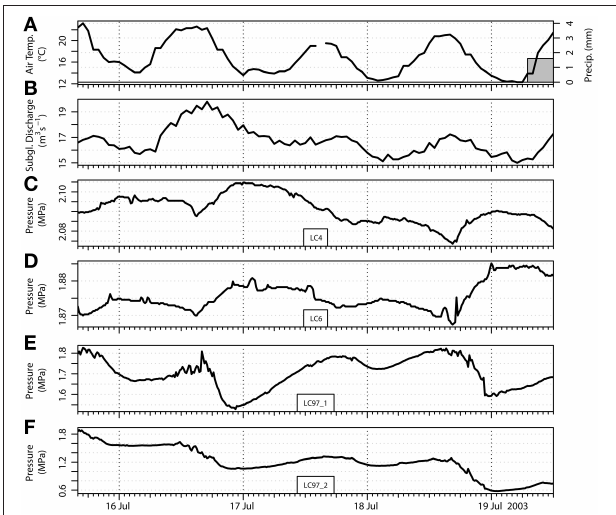
FIGURE 4 | Enlargement of Figure 3 for the period 16–19 July 2003 showing the anti-correlated pressure between two pairs of load cells. (A) Hourly air temperature and daily precipitation at Glomfjord (30 m a.s.l.); (B) calculated subglacial discharge; (C–F) load cell pressure.